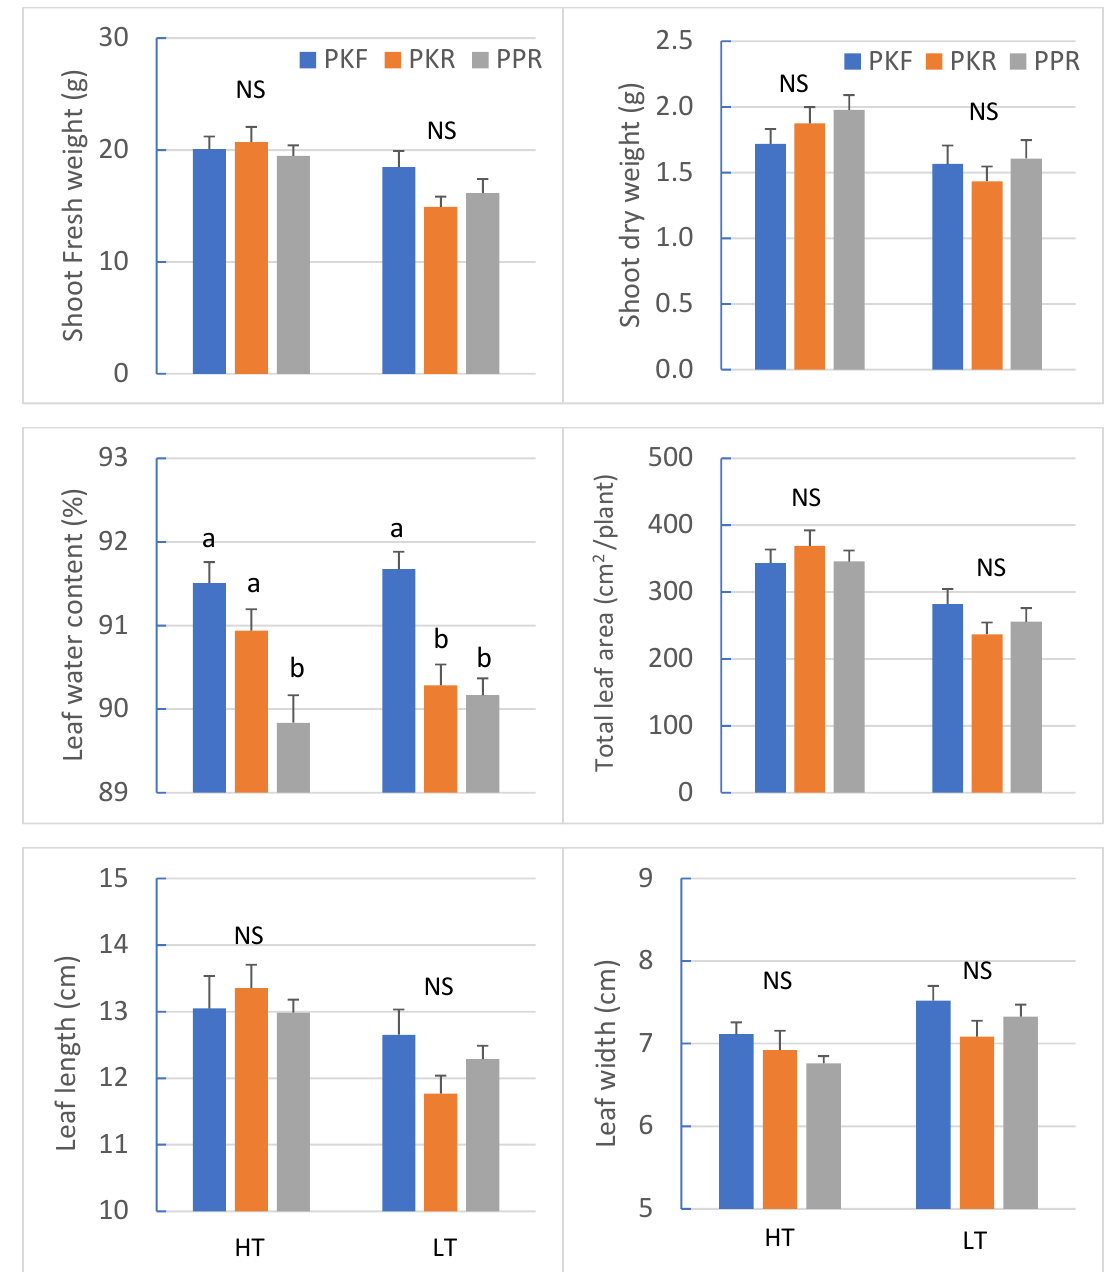
Figure 3. Shoot fresh weight, dry weight, leaf water content, leaf area, and leaf length and width of ‘Petite Star’ pak choy ( Brassica rapa subsp. Chinensis ) plants grown under three light spectra (PKF, PKR, PPR) and two temperatures: high temperature (HT, ≈ 30 ◦ C) and low temperature (LT, ≈ 21 ◦ C). Vertical bars represent standard errors. Different letters for the same temperature level indicate significant differences among three light spectra at p ≤ 0.05. NS indicates no significant differences among the light spectra.